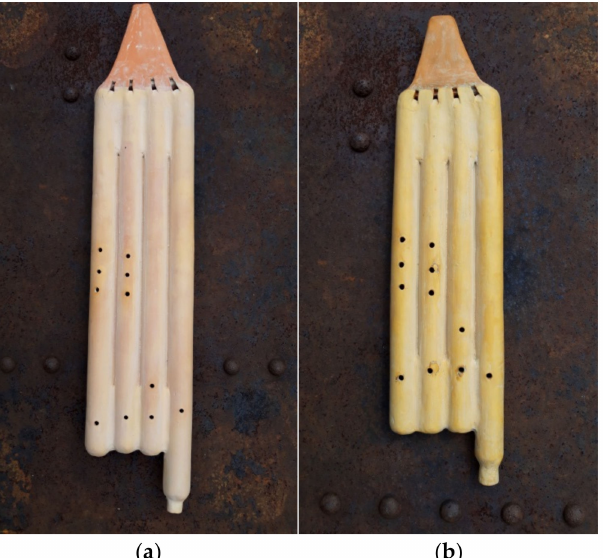
Figure 23. Experimental quadruple flute models made by Osvaldo Padr ó n (2020): ( a ) “Zacuala